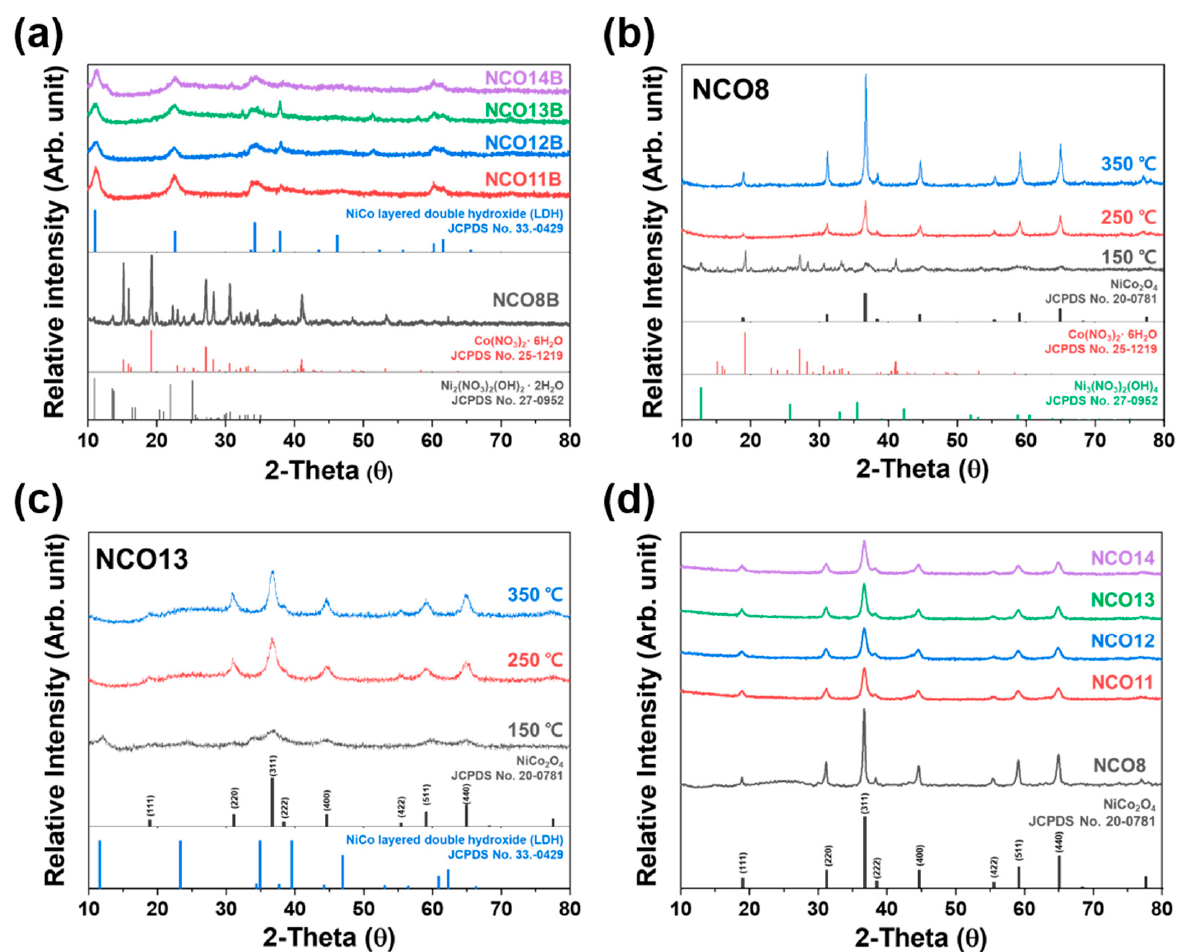
Figure 1. XRD patterns of ( a ) NCOBs (8B, 11B, 12B, 13B, and 14B), ( b ) NCO8 by different annealing temperatures (150, 250, and 350 °C), ( c ) NCO13 by different annealing temperatures (150, 250, and 350 °C), and ( d ) NCOs (8, 11, 12, 13, and 14) after annealing at 450 °C.